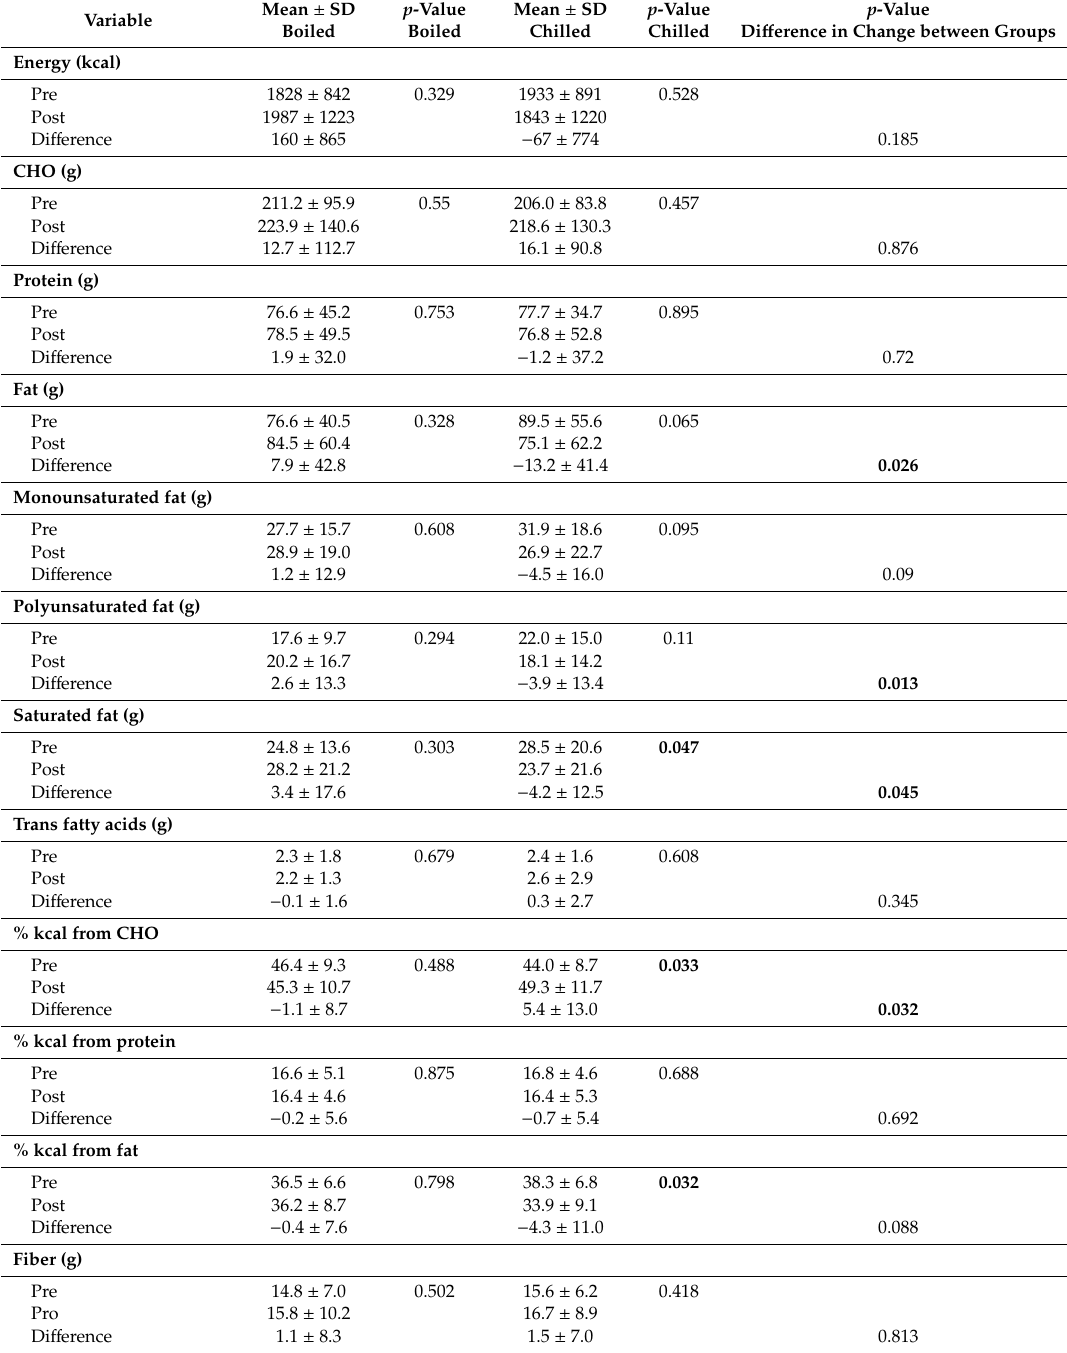
Table 2. Comparison of mean nutrient intake before and after each potato